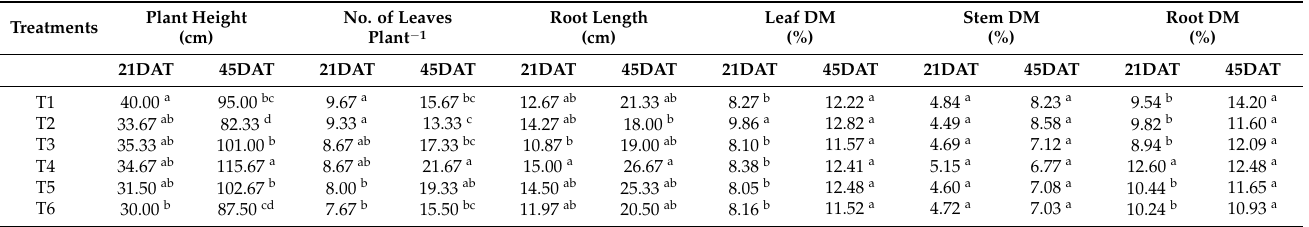
Table 1. Effects of chemical (mono-super phosphate), organic (rock phosphate), and PGPB (biofertil- izer) treatments on some vegetative-growth traits (plant height (cm), no. of leaves plant − 1 , root length (cm), leaf DM%, stem DM%, and root DM%) of tomato plants grown under greenhouse conditions 21 and 45 days after transplantation (DAT).